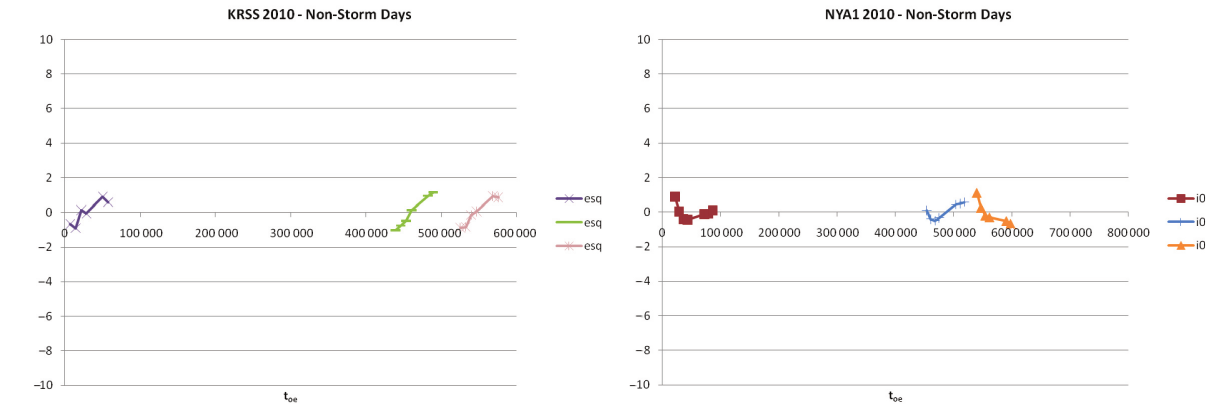
Fig. 17. Inclination for three stormless days in 2010 using cPOS stations (NYa1)